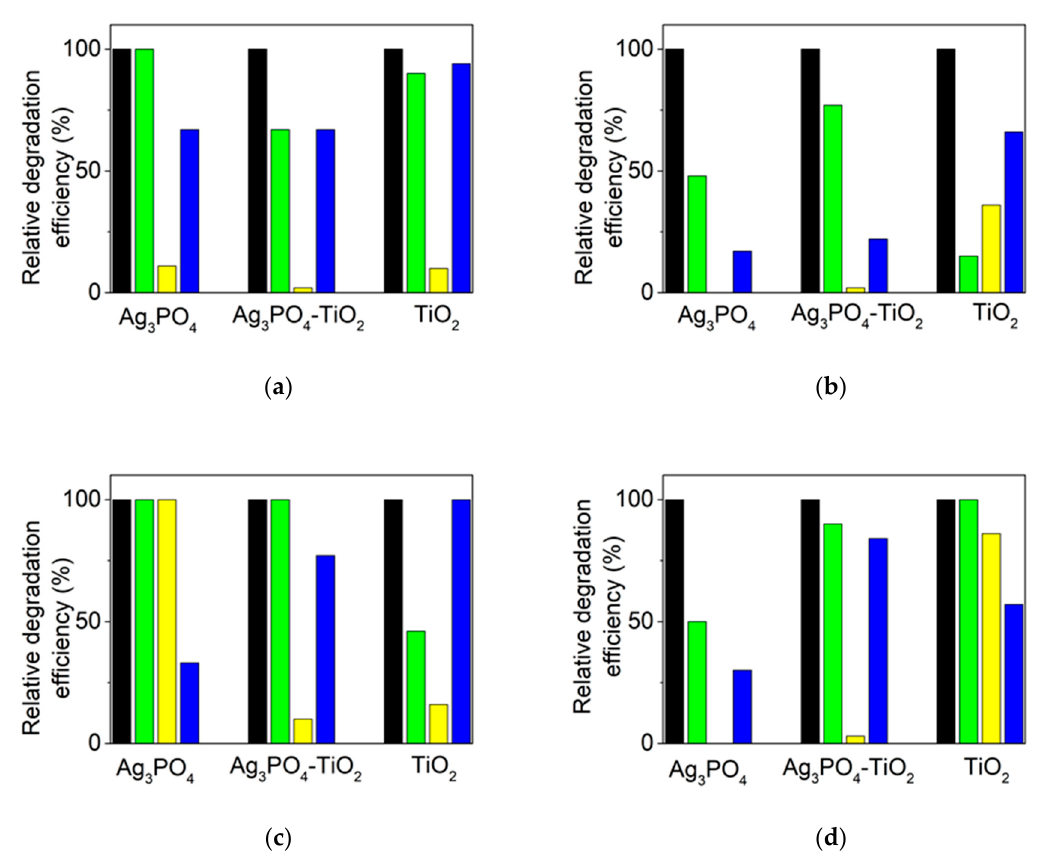
Figure 6. Effect of different scavengers on the relative degradation efficiency of TZ ( a ), OII ( b ), RhB ( c ), and BB ( d ) in the presence of Ag 3 PO 4 , hybrid Ag 3 PO 4 –TiO 2 , and TiO 2 , under 420 nm irradiation. No scavenger is shown in black, 2-propanol (1 × 10 − 1 M) is shown in green, p -benzoquinone (1 × 10 − 4 M) is shown in yellow, and ammonium oxalate (1 × 10 − 4 M) is shown in blue. Initial concentrations: 5 × 10 − 5 M (dye) and 0.5 g/L (photocatalyst) in aerated aqueous media.